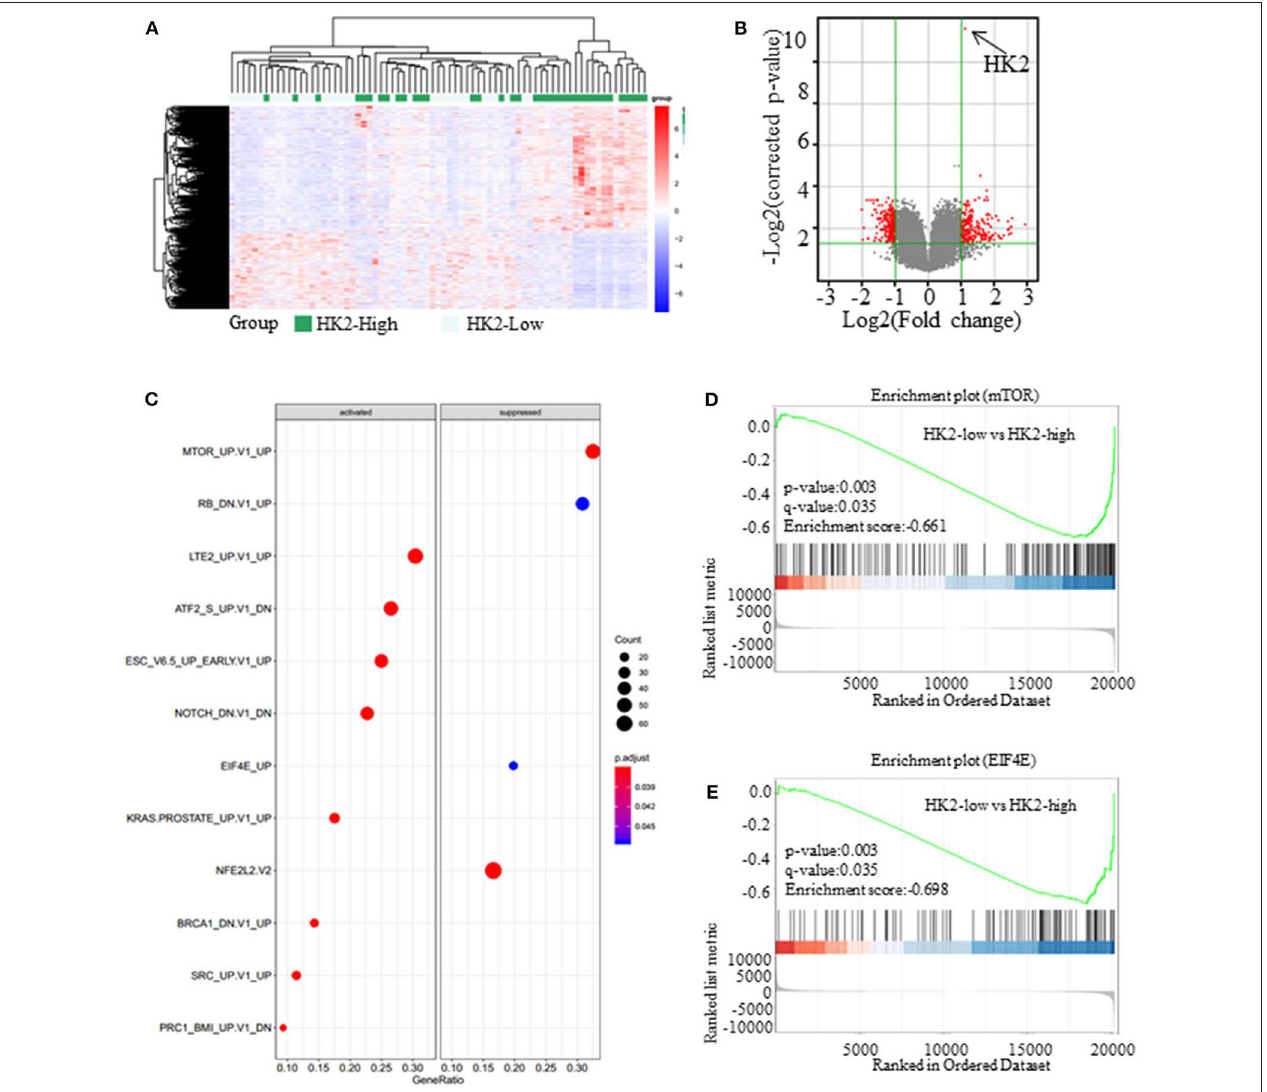
FIGURE 3 | Inhibiting HK2 induces activation of the AMPK signaling pathway. (A) The expression of different genes in High-HK2 and Low-HK2 samples from the GSE43580 cohort. (B) Volcano map showing the differentially expressed genes (fold change > 2, p < 0.05, red dots are up-regulated genes and down-regulated genes). (C) GSEA shows the differential signaling pathways enriched from differential genes. (D) Running enrichment score of mTOR in GSEA. (E) Running enrichment score of mTOR in GSEA.